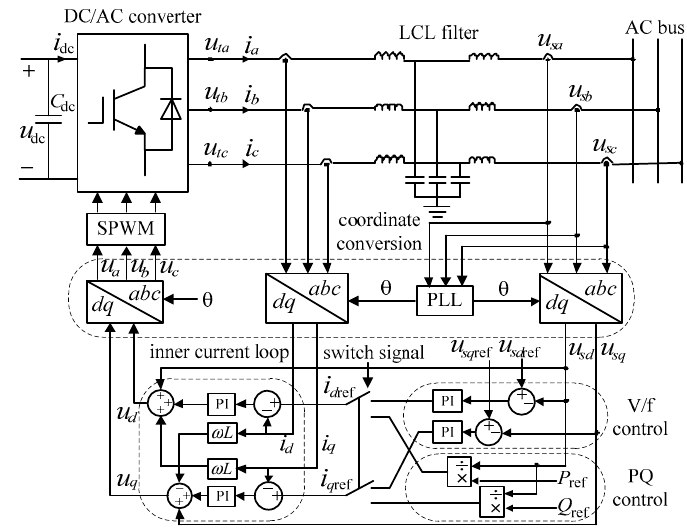
Figure 4. Control schematic of the DC/AC converter.